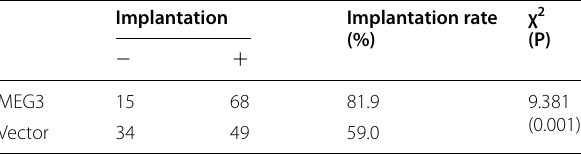
Table 2 Embryo implantation rate of MEG3 group and Vector group Implantation